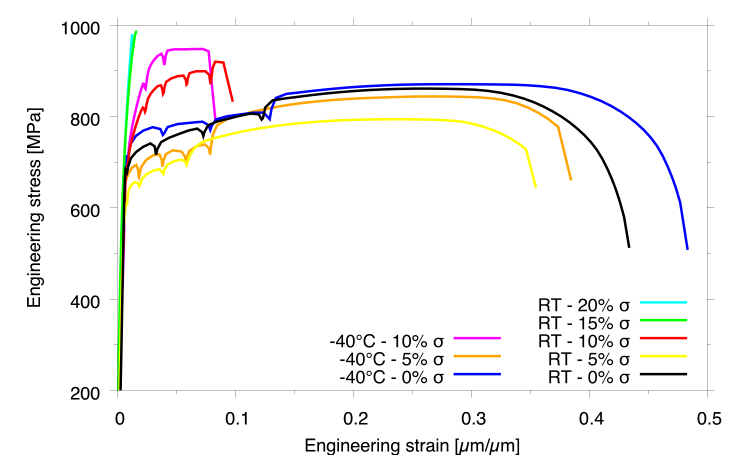
Figure 4. Tensile test curves obtained during the in situ tensile tests. The drops in the curves are when the test is paused for acquiring EBSD data.